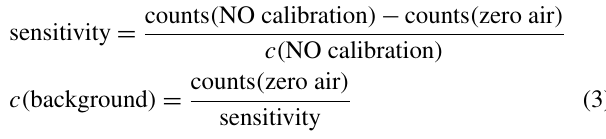
nel using the type 2 quartz converter. The detection limit is higher when using the type 1 converter, but it is difficult to determine due to the observed memory effects and is esti- mated at > 10 pptv.